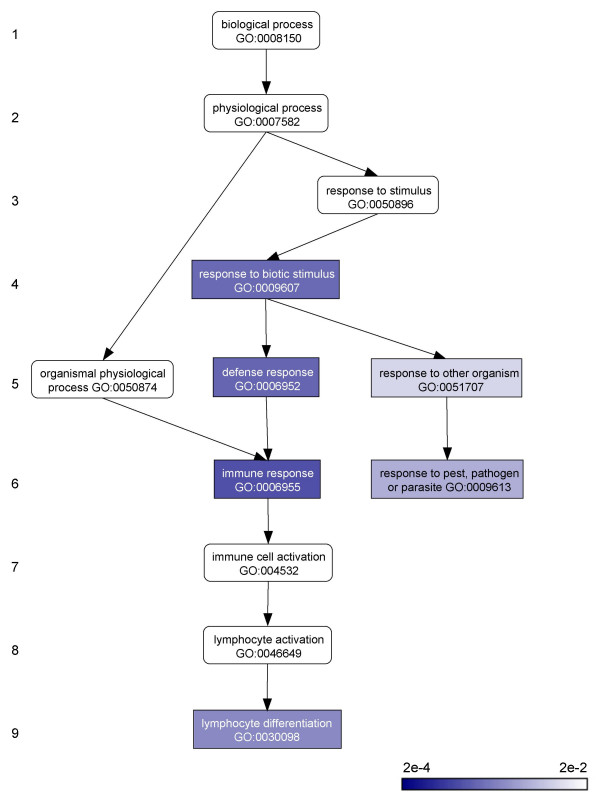
Path on the GO biological process graph leading to overrepresented functions related to immune response. Hierarchical levels of the directed acyclic GO graph are shown on the left. Nodes in the graph represent individual GO annotation terms. Nodes are color coded according to the statistical significance level for their overrepresentation. Edges in the graph represent parent-child relationships between GO terms.